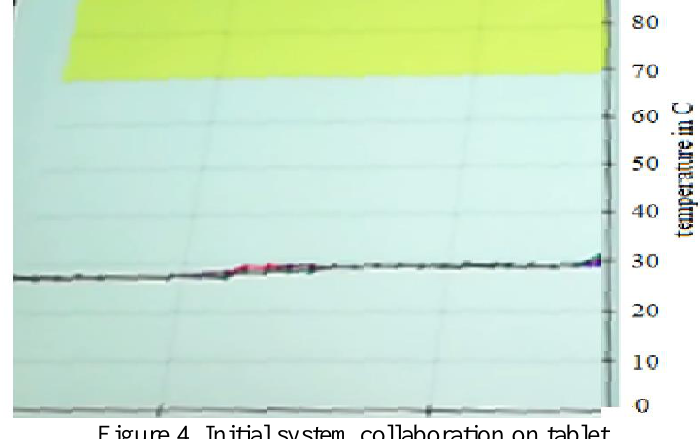
Figure 4. Initial system collaboration on tablet